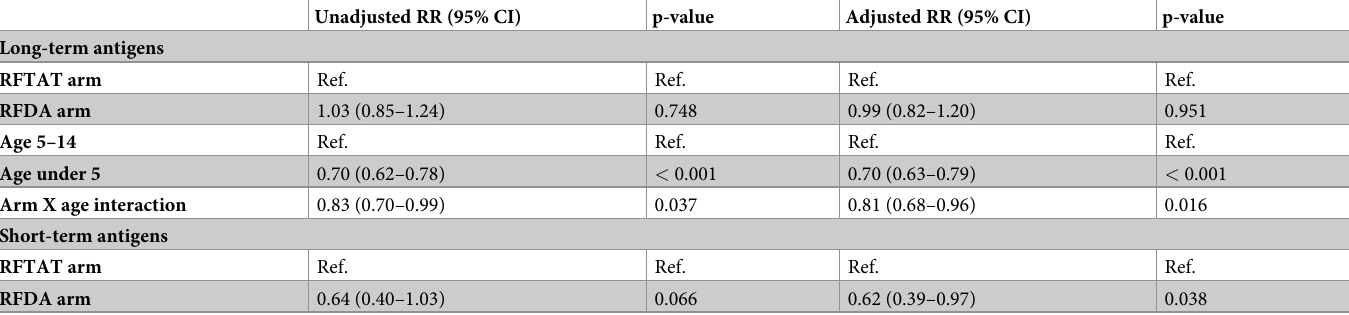
Table 2. Results from a log-binomial regression model of seroprevalence to long-term antigens (AMA-1, GLURP-R2, MSP1-19, N = 5,152 unadjusted, 5,085 adjusted, individuals), and short-term antigens (GEXP18, H103/MSP11, HSP40 Ag1, Hyp2, CSP, and MSP2_CH150, N = 5,100 unadjusted, 5,036 adjusted, individ- uals) in 16 HFCA.